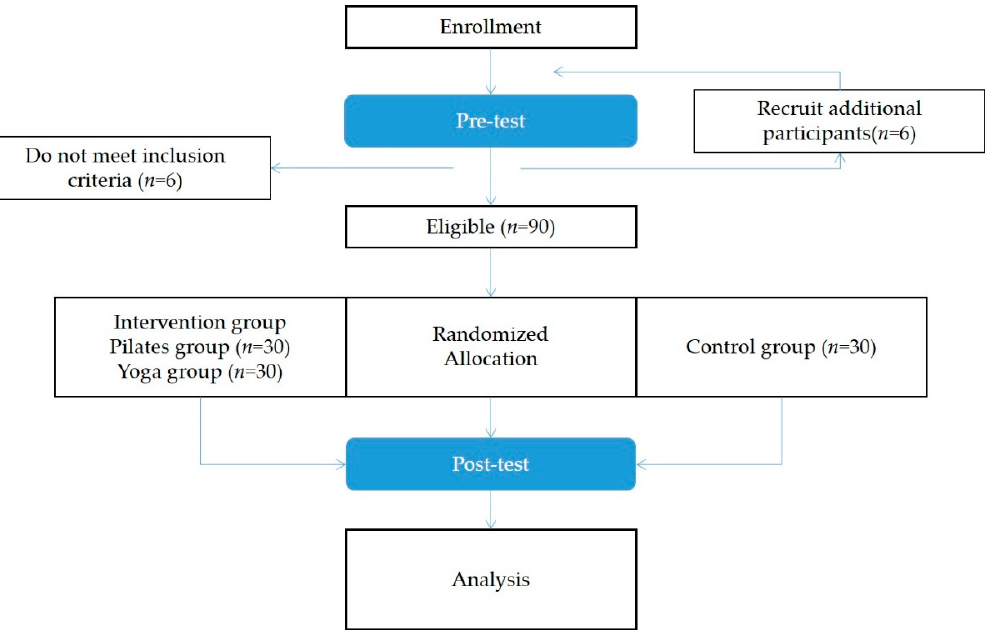
Table 1. Characteristics of participants at pretreatment.